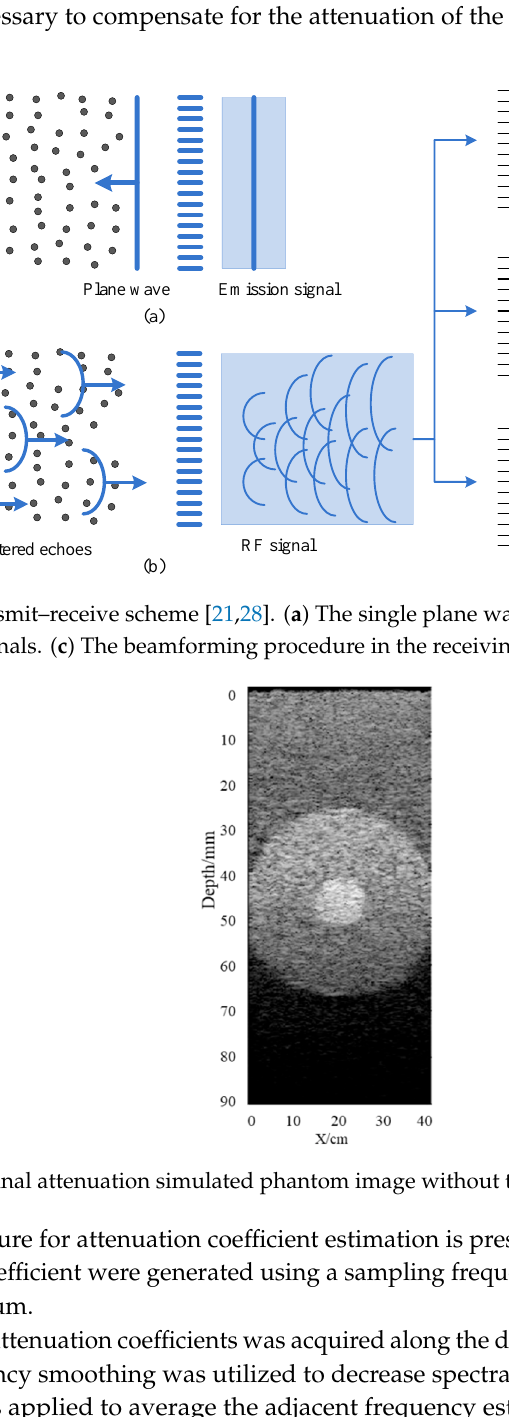
Figure 2. The breast ultrasound image reconstruction flow chart.